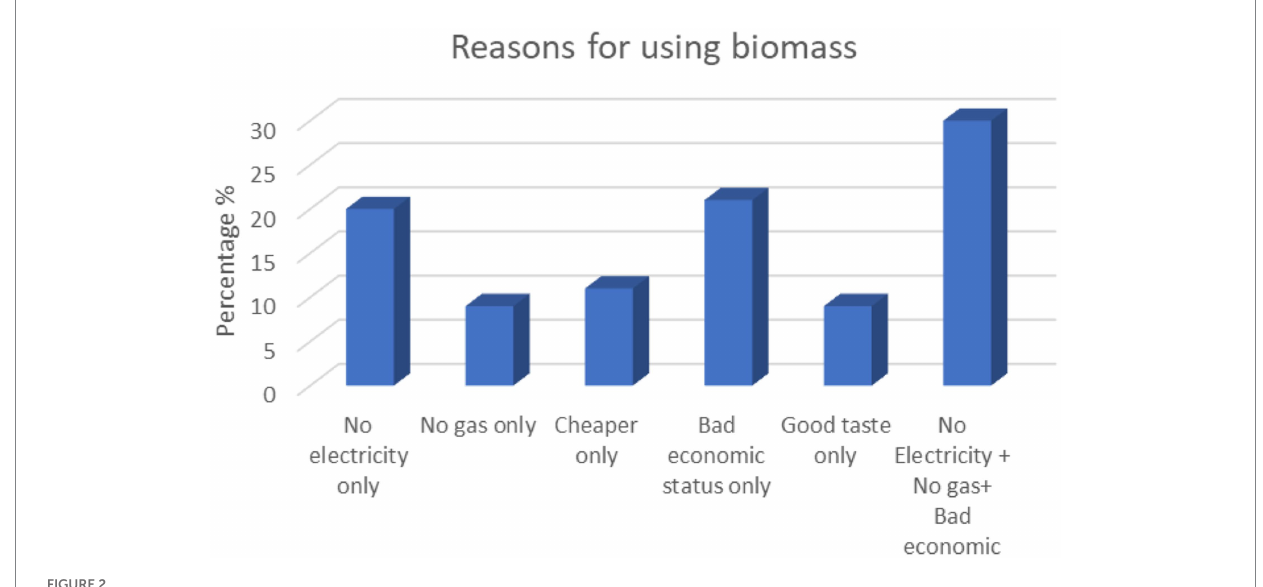
FIGURE 2 Reasons for biomass fuel use among study population.